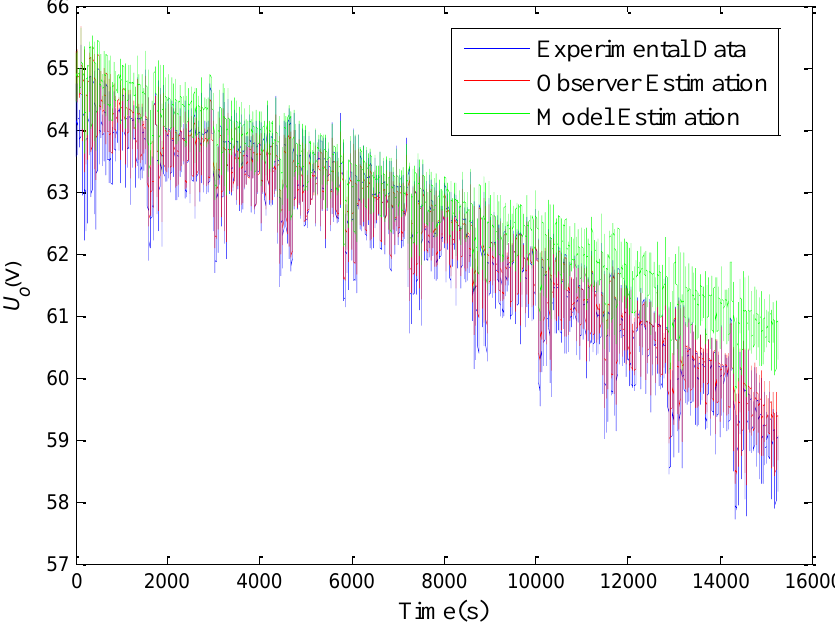
Figure 16. Estimation of the battery terminal voltage.